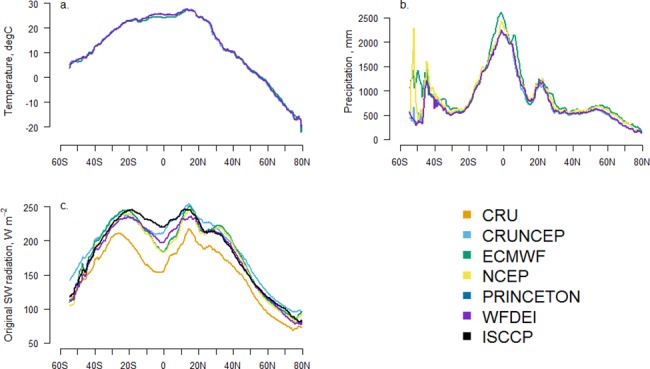
Comparisons of the climatological zonal mean of annual average (1982–2010) of three climate variables among the six climate datasets, i.e. CRU [14], CRUNCEP [30], ECMWF [31], NCEP [32], PRINCETON [17] and WFDEI [18].The variables are temperature (panel a), precipitation (panel b) and shortwave radiation (panel c). The black line in panel (c) shows the zonal mean of annual average (1984–2000) of ISCCP radiation [33]. The comparisons are conducted for terrestrial areas only. The spatial distribution of each climate variable can be found in S4–S6 Figs.